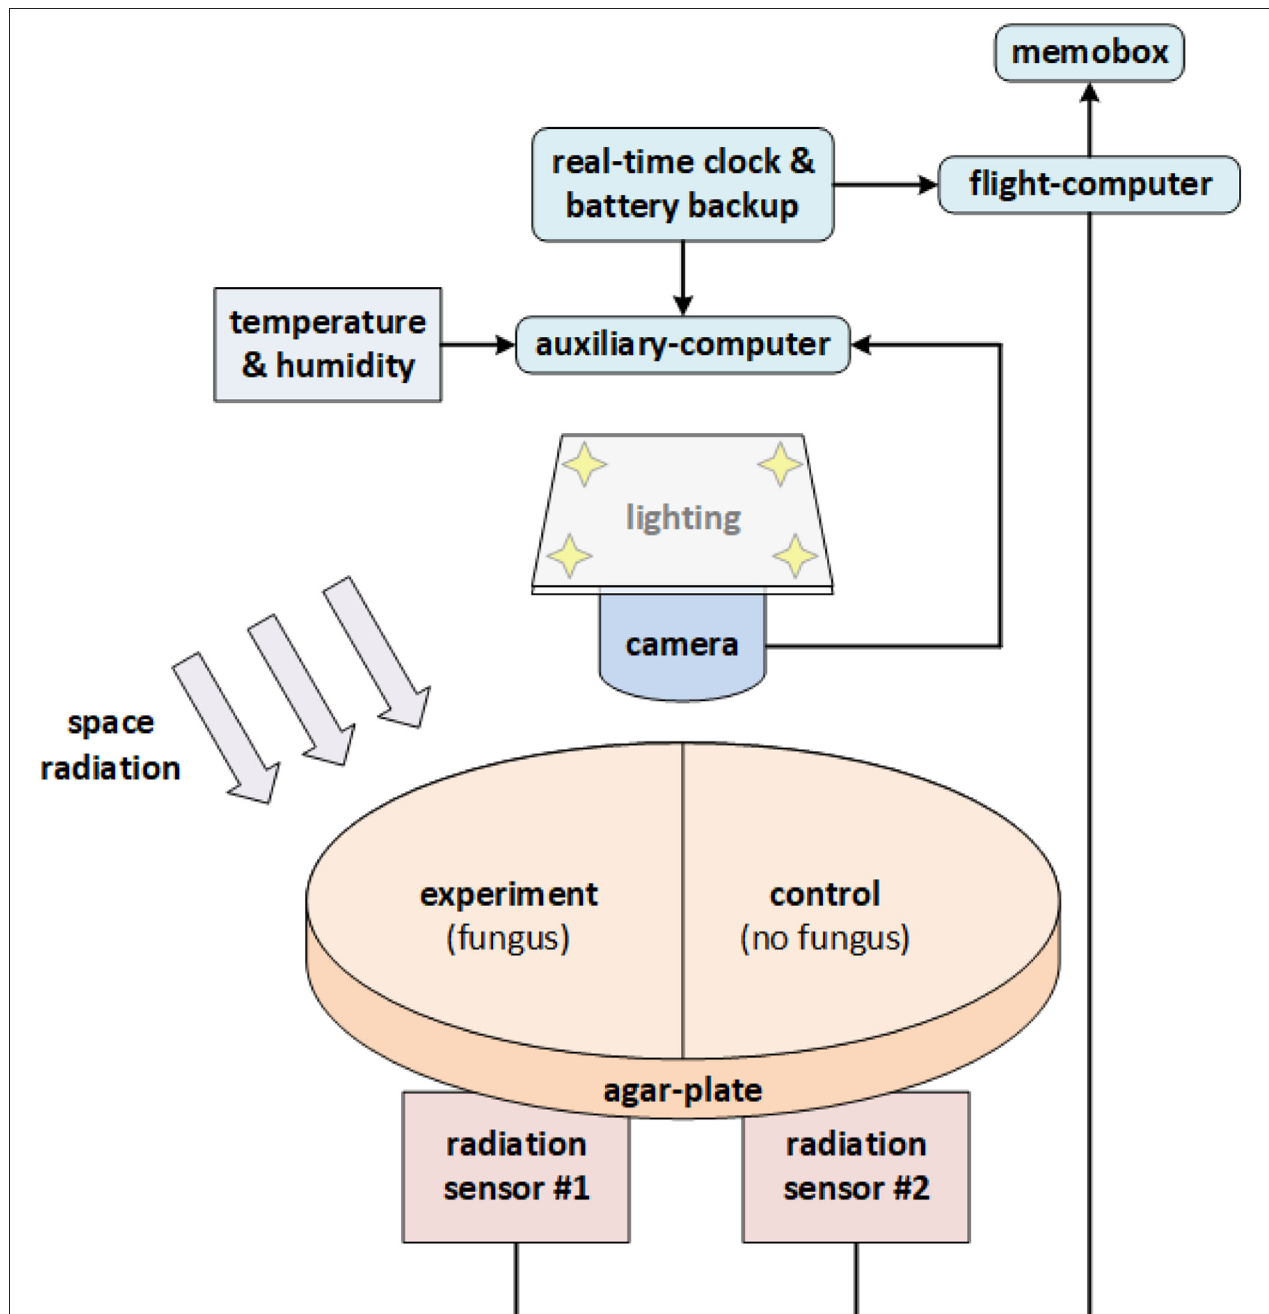
FIGURE 1 | Block chart of the experimental flight-hardware setup. The single (split) Petri dish accommodated both the experiment (agar + fungus), as well as the negative control (agar only). The two (square) radiation sensors were situated in parallel directly beneath the Petri dish (one for each side). Note that “shielding” is one-sided only (for simplicity of experimental setup and to reduce